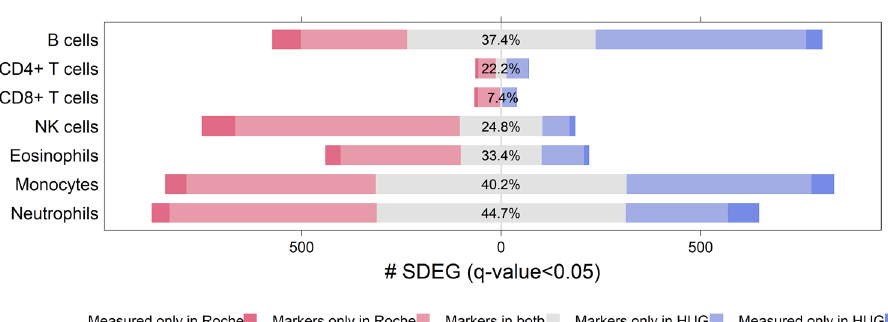
Figure 5. Percentile overlap of cell-type specific SDEGs between Roche and HUG datasets, quantified by Jaccard index (intersection over union). SDEGs are detected by subtype-specific OVE-sFC test with q-value <